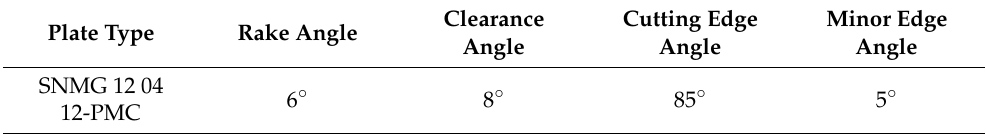
Table 2. Tool parameters of SNMG 12 04 12-PMC—Sandvik Coromant. Plate